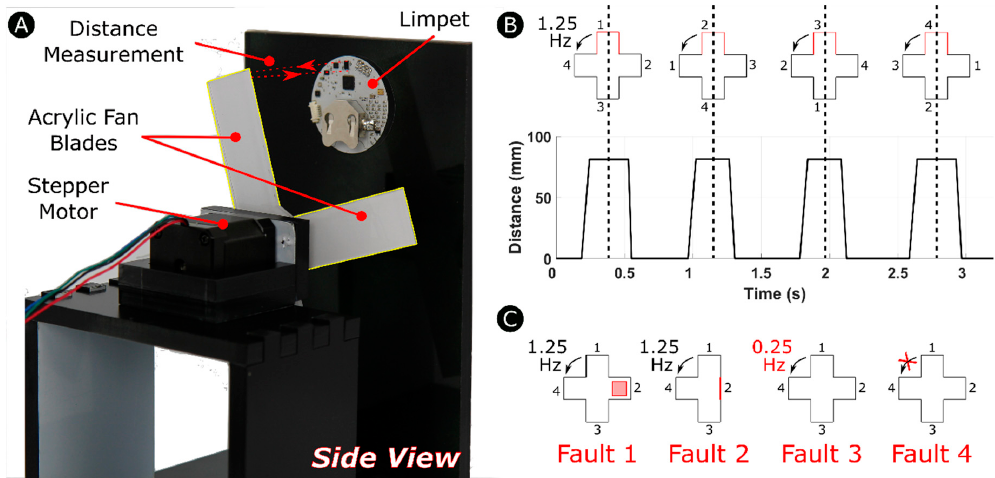
Figure 3. ( A ) Experimental setup for distance-based fault detection. We fixed the Limpet in place and used the fan to mimic a small wind turbine. ( B ) Schematic of the fan and distance profile for normal operation mode. Each peak corresponds to one of the four fan blades detected. ( C ) Schematic of the faults introduced to the system.